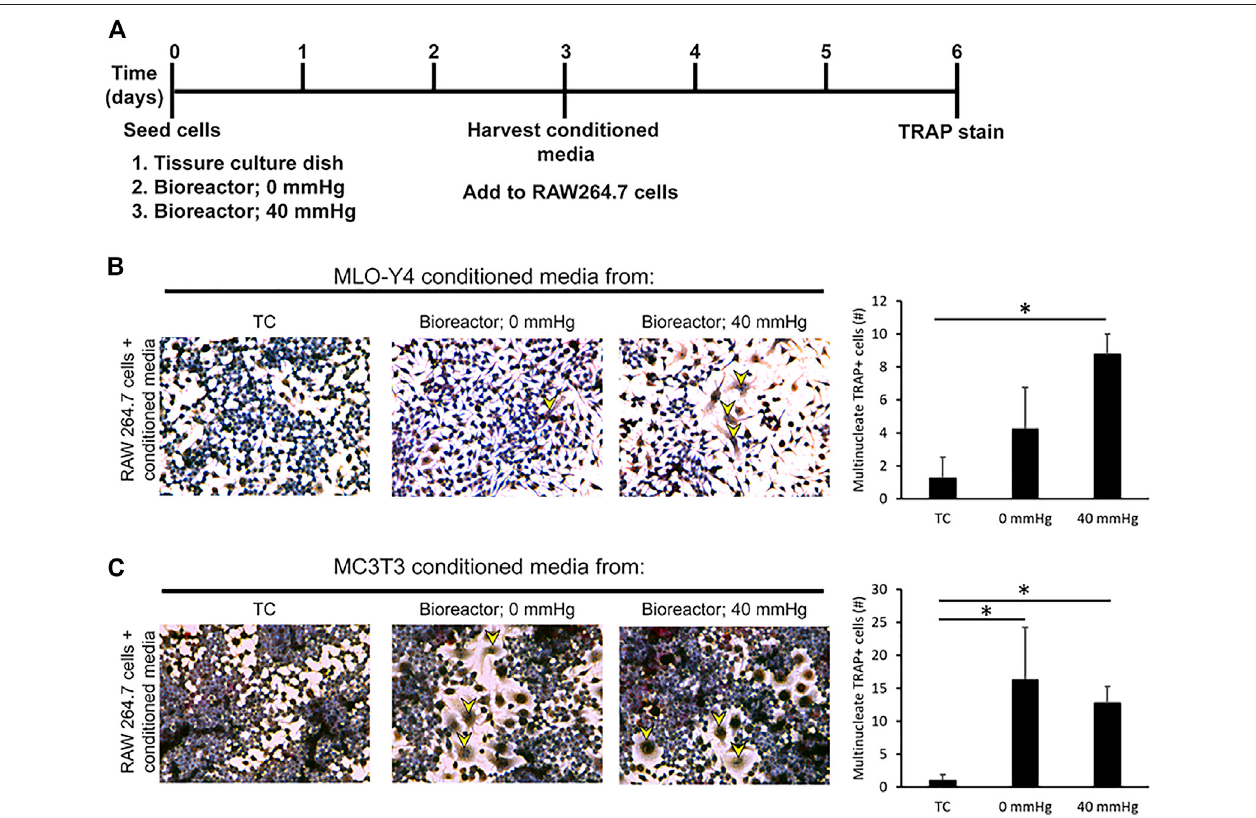
FIGURE 4 | Conditioned media from bone cells grown in bioreactor induces the formation of multinucleated TRAP + cells. (A) Experimental set up. (B) Response and quanti fi cation of RAW264.7 cells incubated with an addition of MLO-Y4 conditioned media harvested from TC, bioreactor (0 mmHg), and bioreactor (40 mmHg). TRAPpositivecellsareindicatedbyyellowarrowheads.ThenumberofTRAP+cellswith2ormorenucleiwascounted. (C) ResponseofRAW264.7cellsincubatedwith an addition of MC3T3 conditioned media harvested from TC, bioreactor (0 mmHg), and bioreactor (40 mmHg). Data are presented as mean ± SD from three independent experiments. * p ≤ 0.05 vs.